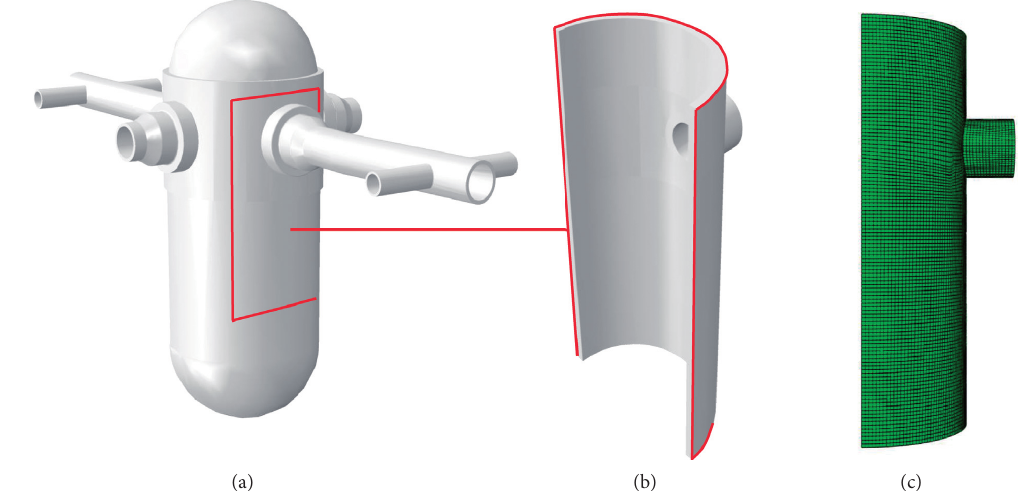
Figure 1: (a) Geometry of RPV, (b) simplified RPV model, and (c) finite element meshed model.